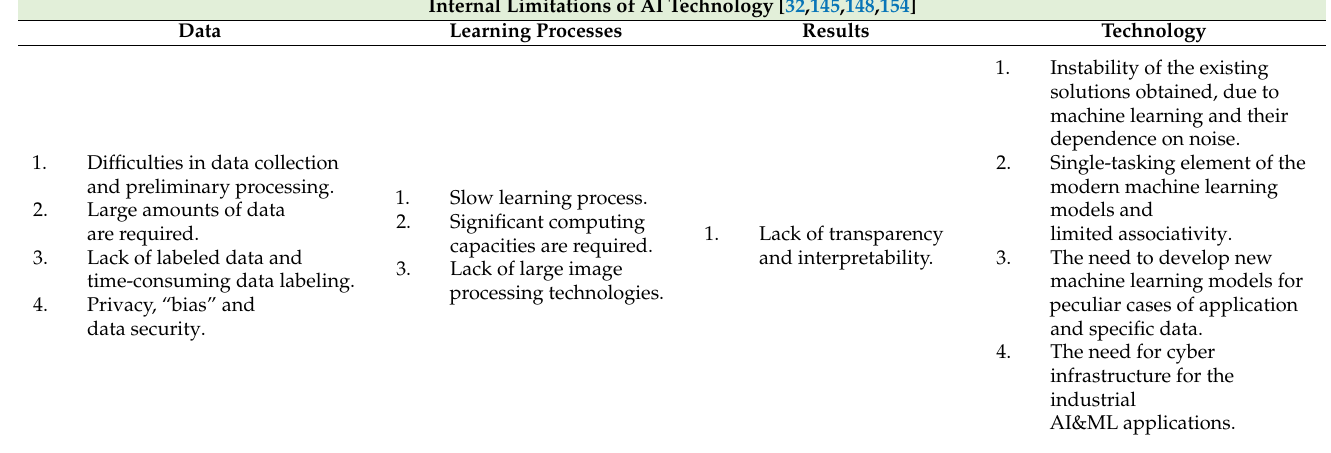
Table 2. Internal limitations of AI